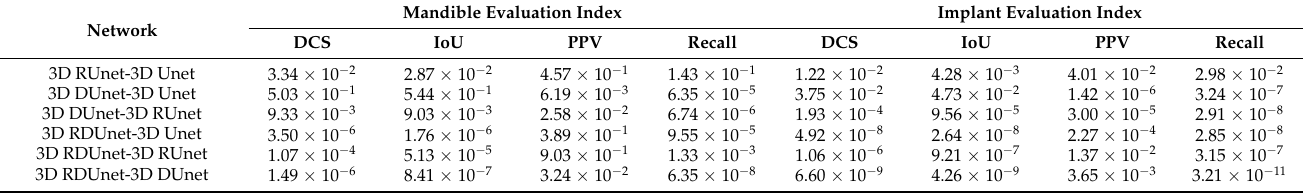
Table 3. p values among the evaluation metrics of the four approaches for statistical significance